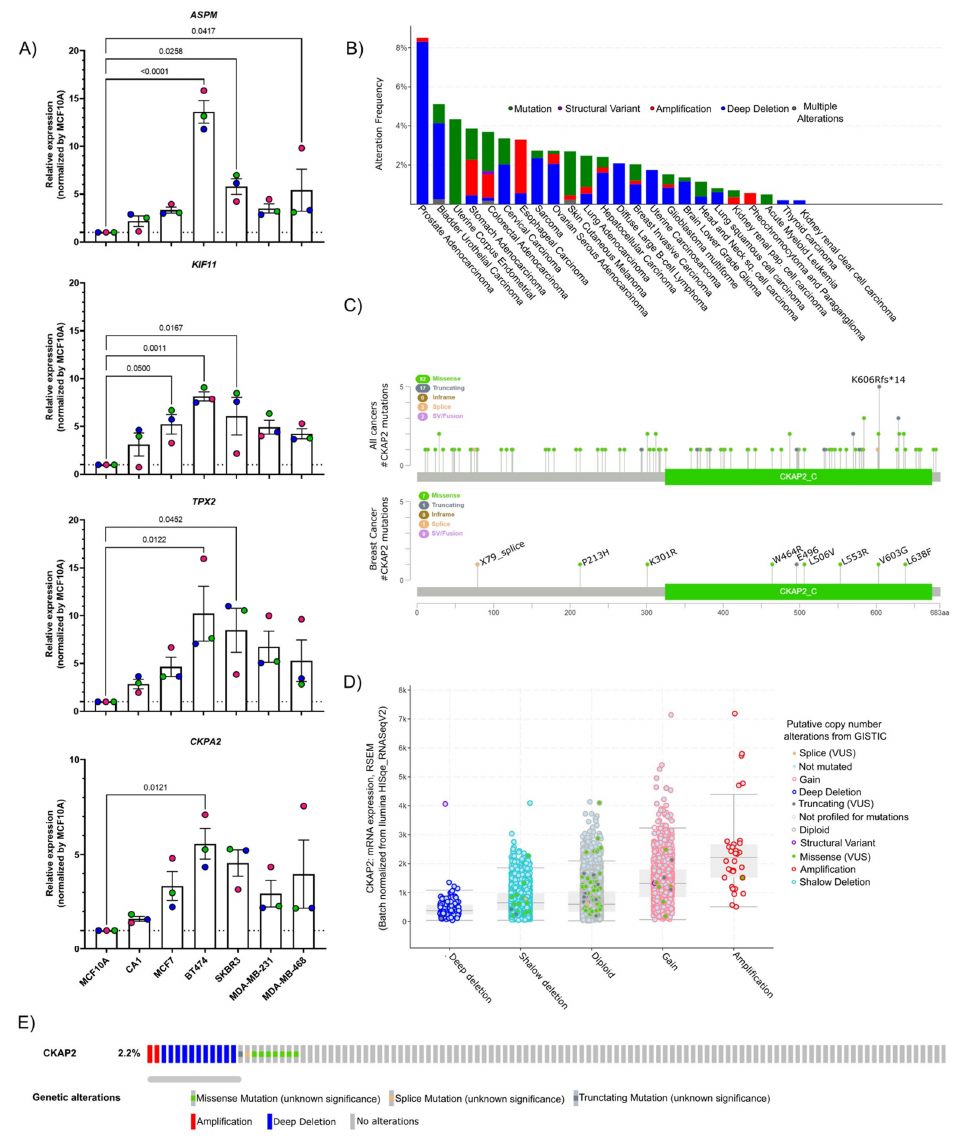
Figure 2. Validation of the data from HTA by qPCR and CKAP2 mutation analysis. ( A ) Four genes were selected and validated by RT-qPCR in different breast cancer cell lines. GAPDH and HPRT1 were used as the house-keeping genes to normalize mRNA-based expression data using the 2 −ΔΔ CT method. ( B ) Bar chart of CKAP2 mutation in pan-cancers from cBioPortal. The red bars indicate gene amplifications, blue bars are homozygous deletions, green bars are non-synonymous mutations, gray bars indicate multiple alterations. ( C ) Lollipop plot showing the distribution of CKAP2 mutations across the coding protein from all cancers and BC. The y-axis represents the number of mutations. The x-axis represents the amino acid numbers from the domain start and stop positions. ( D ) Correlation plots illustrating the relationship between mRNA expression levels (RSEM) and putative copy number changes (Genomic Identification of Significant Targets in Cancer-GISTIC2) for the CKAP2 gene. Deep deletion, homozygously deleted; Shallow deletion, heterozygously deleted; Diploid, two alleles present; Gain, low-level gene amplification event; Amplification, high-level gene amplification event. ( E ) Oncoprint of genomic alterations found in CKAP2 in TCGA-BC. Red bars indicate gene amplifications, blue bars are deep deletions, green bars are missense mutations, gray bars indicate truncating mutations. LumA: luminal A; LumB: luminal B, HER2+: human epidermal growth factor receptor 2 positive; TN: triple negative breast cancer; VUS: variance of unknow significance; CKAP2_C: cytoskeleton-associated protein 2